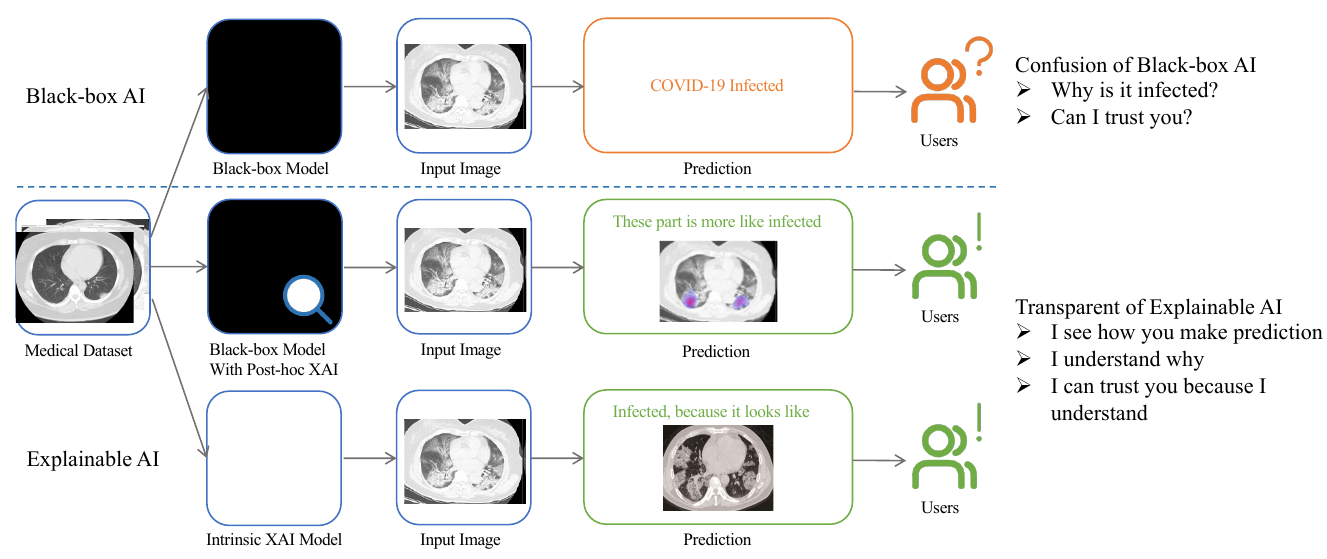
Figure 1. Flowchart of visual comparison between black-box and explainable artificial intelligence, and how the results affect the user. The top branch shows the process of a black-box model. Typically, it provides only results such as classes (e.g., COVID or non-COVID). The other two branches (middle and bottom) represent two XAI methods, referred to in Section 3.1. Specifically, the XAI model (middle) shows the example of saliency map, and the second one (bottom) is the prototype method, as explained in Sections 4.1 and 4.6, respectively. An example of a CT image obtained from the COVID-19 CT scan dataset